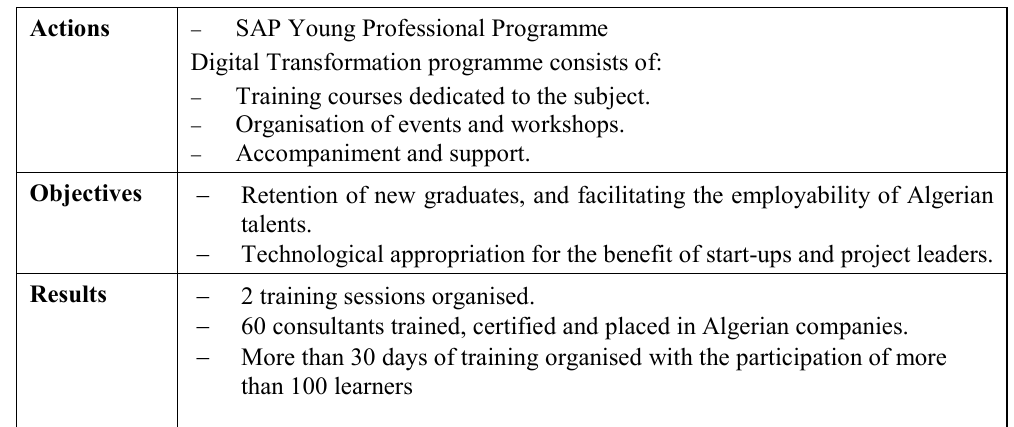
Table 5. Objectives, Actions and Results of the Period 2019–2020